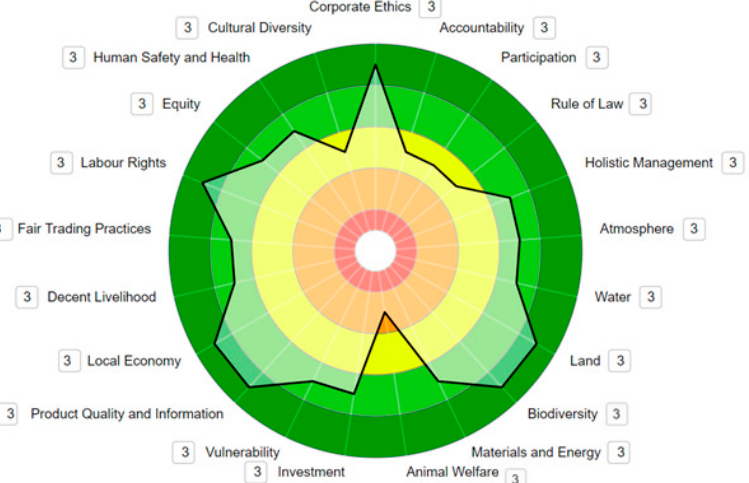
Figure 12. SAFA assessment result of the start ‐ up as spider graph. The number near indicators suggest the data quality according to Table 4, and also, the colour in the circles represent the range score. As reported in Table 3, the colour means the performance score: Dark green: Best; light green: Good; yellow: Moderate; orange: Limited; red: Unacceptable. Like other start ‐ ups, the implementation of various species leads to a high score in environmental indicators, here even higher due to the introduction of exotic species valuable to the local market.